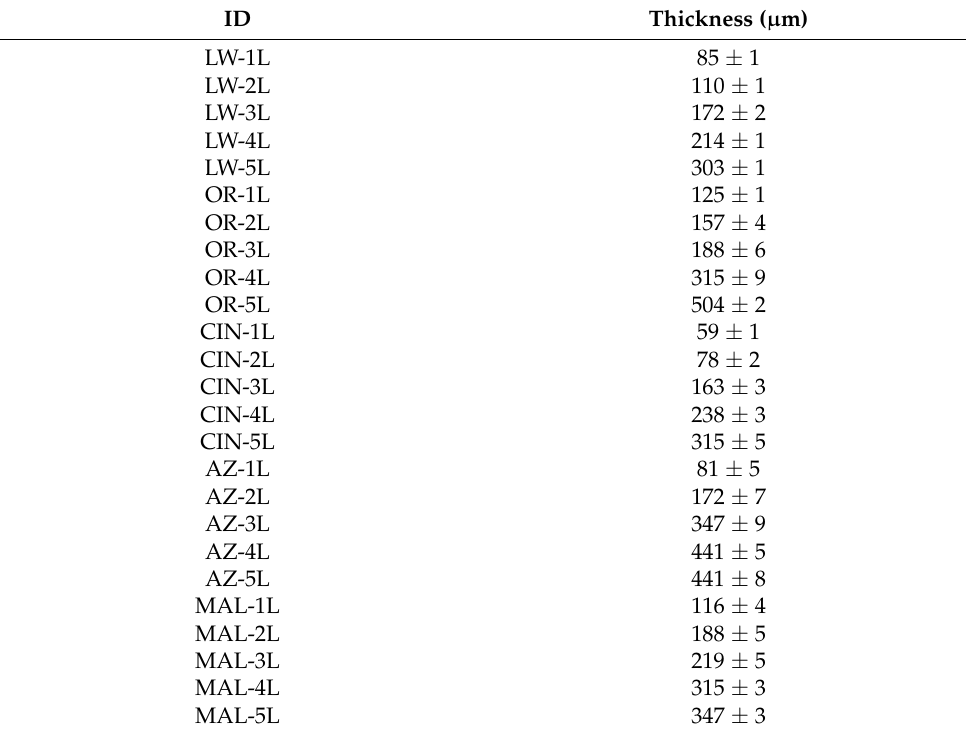
Table 2. Thickness of the paint layers (one to five layers, 1L to 5L), as measured by polarized light microscopy. LW, lead white-based oil painting mock-ups; OR, orpiment-based oil painting mock- ups; CIN, cinnabar-based oil painting mock-ups; AZ, azurite-based oil painting mock-ups; MAL, malachite-based oil painting